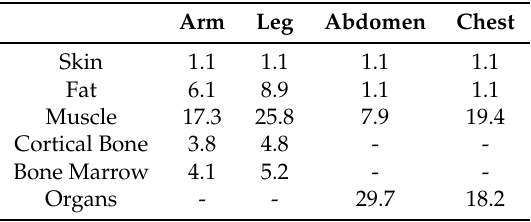
Figure 4. Simulation platform in Computer Simulation Technology (CST) [17]. Table 1. Thickness of Tissue Layers